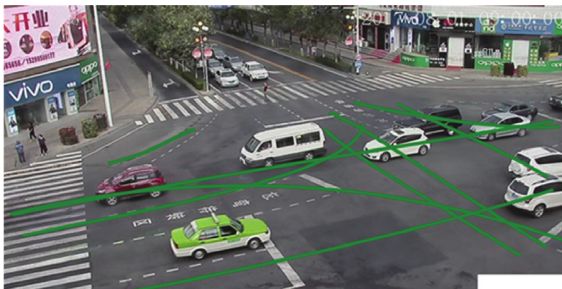
Figure 9: Trajectory data in different phases.